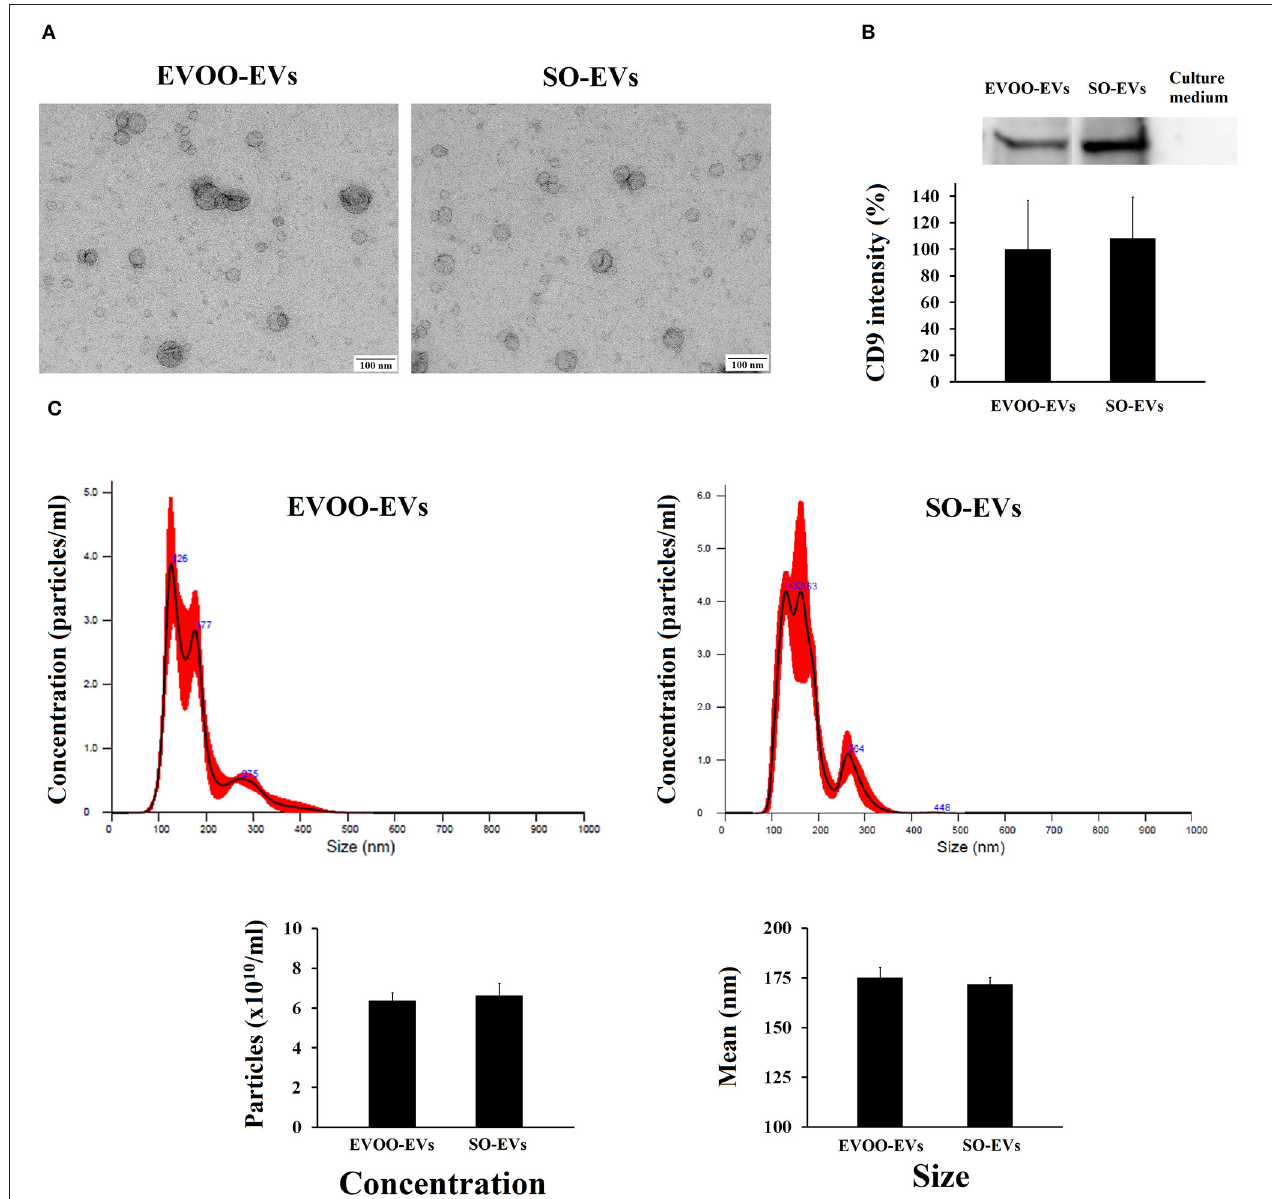
FIGURE 1 | (A) Characterization by electronic microscopy of the EVs secreted by HUVECs incubated with EVOO-derived TRLs (EVOO-EVs) and with SO-derived TRLs (SO-EVs). (B) Graph shows CD9 in the EVOO-EVs, in the SO-EVs and in the culture medium supplemented with exosome-depleted FBS used in the incubations, with representative western blot above for CD69 ( n = 2). (C) Analysis of the concentration and size distribution of EVs by nanoparticle tracking analysis ( n = 2).